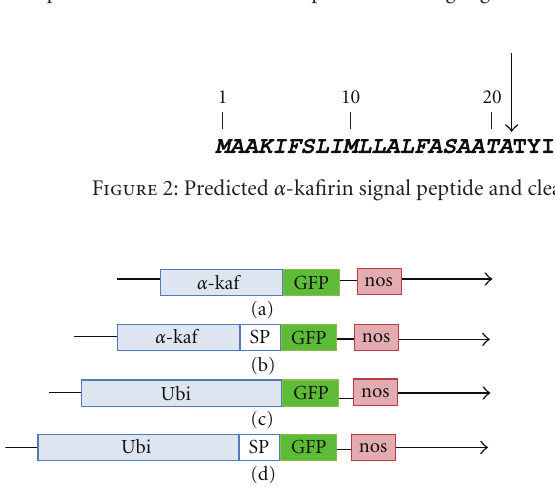
Figure 3: Gene cassettes for promoter and signal peptide (SP) study using GFP as a reporter gene. The α -kaf promoter was used to drive expression of gene cassettes (a) and (b). The Ubi promoter was used to drive constitutive expression of gene cassette (c) and